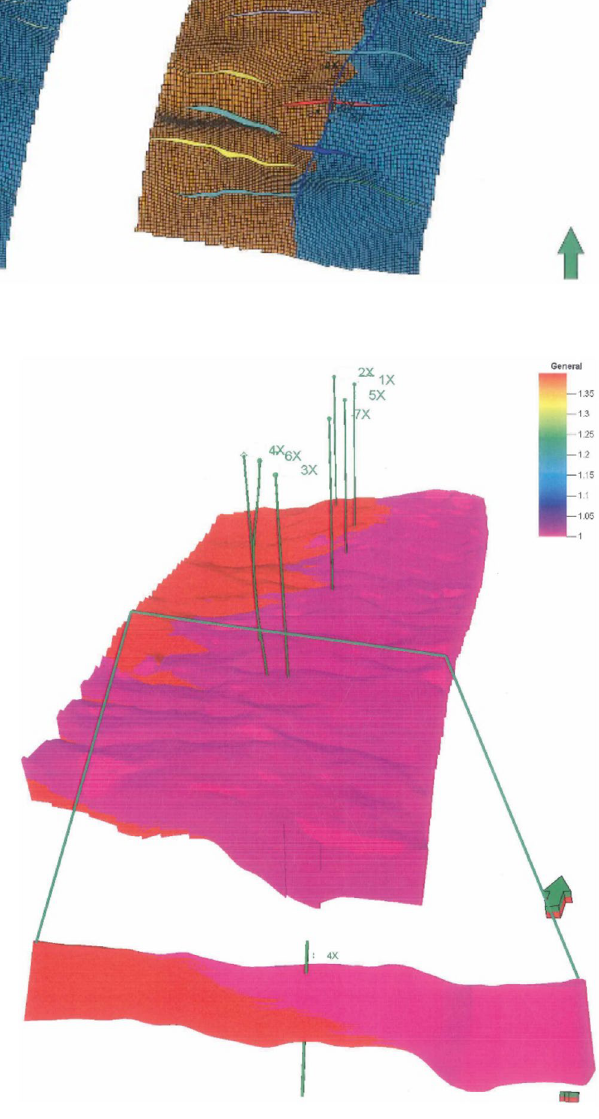
Fig. 21 Area division model